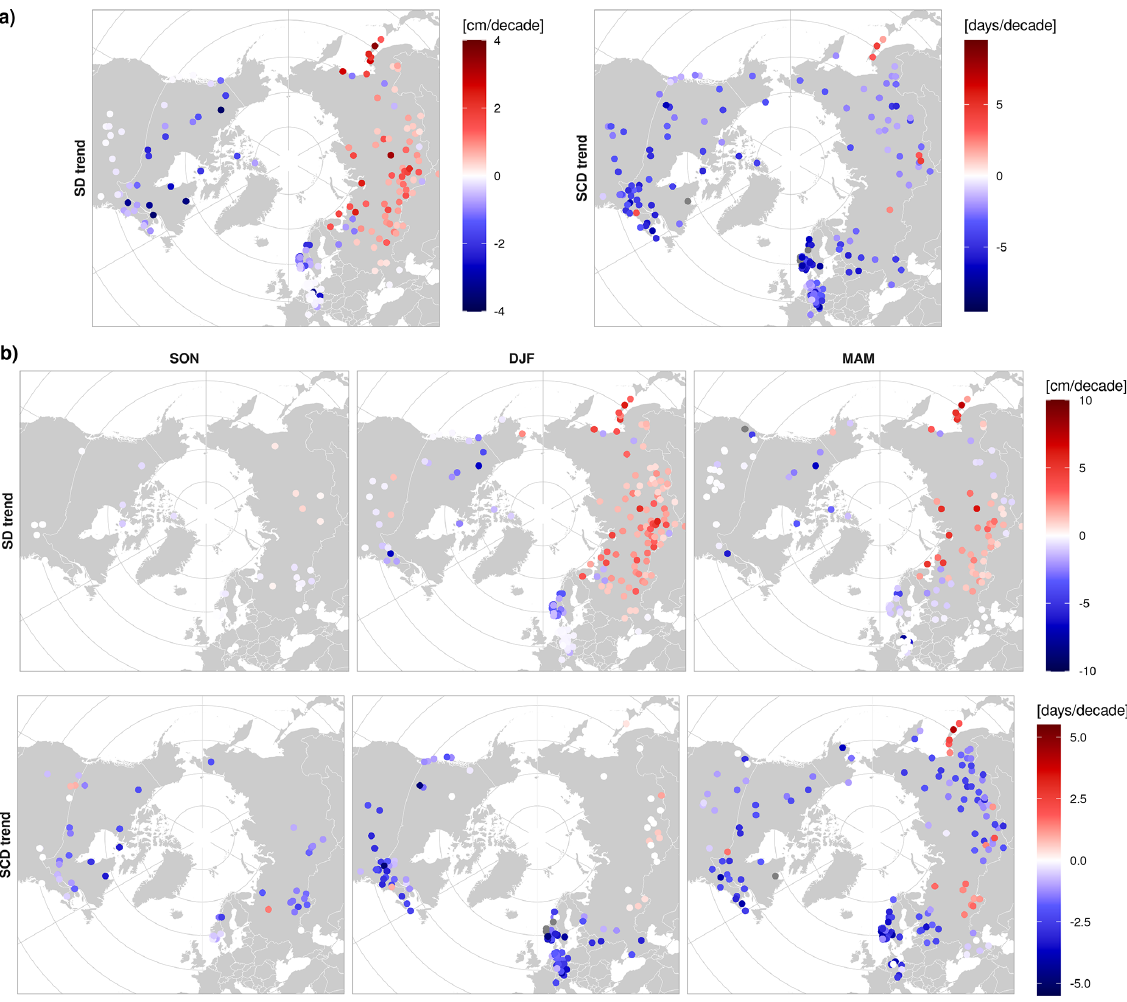
Figure 10. (a) Annual and (b) seasonal decadal trends in snow depth (SD) and snow cover duration (SCD) from 1955 to 2015 based on in situ measurements. Only statistically significant trends ( p value < 0 . 05, Mann–Kendall) are shown.